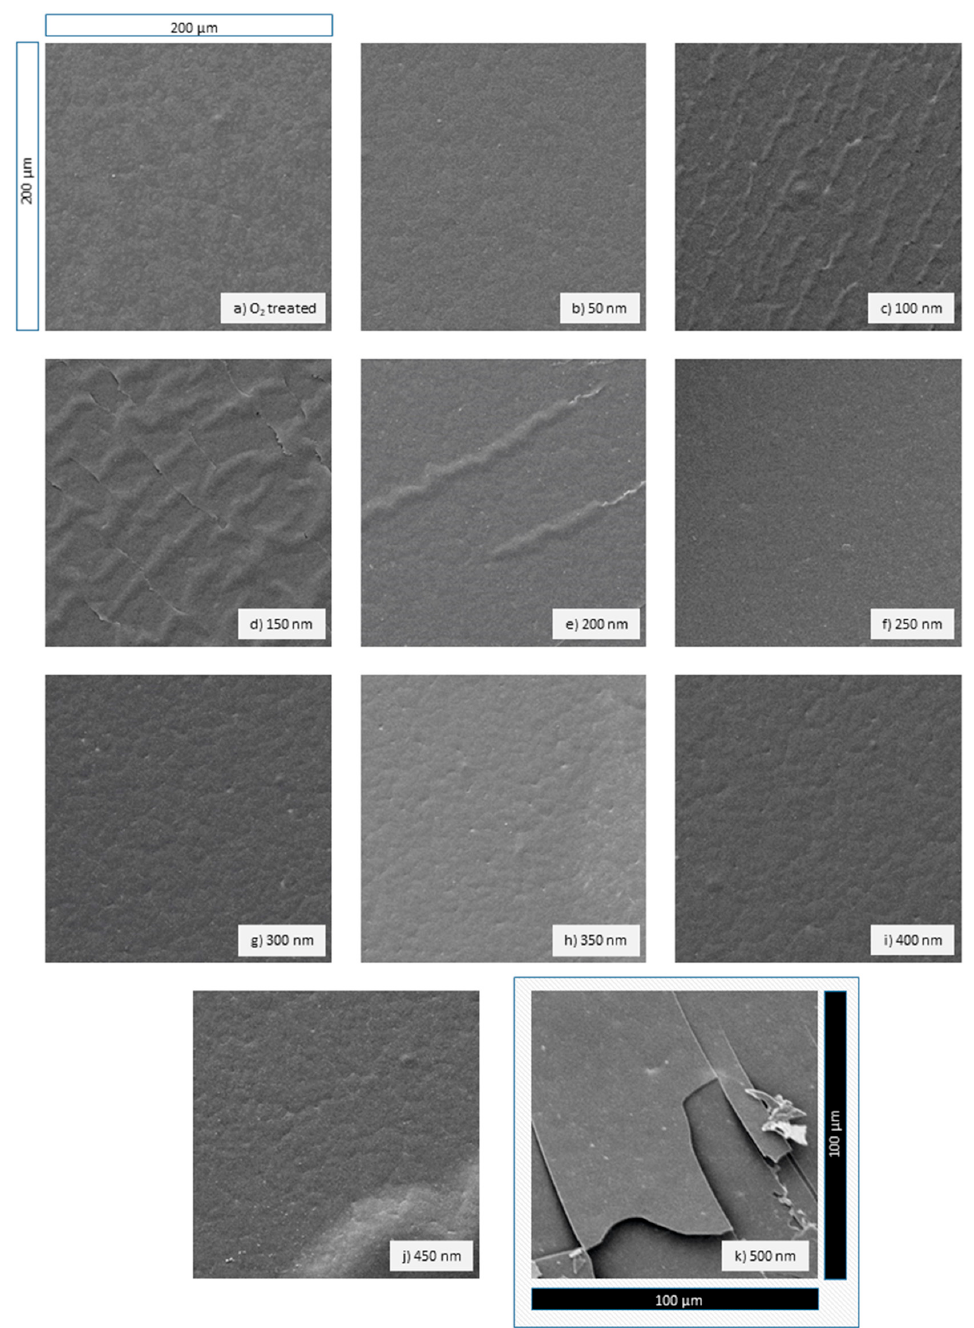
Figure 1. SEM images of PHB treated with O 2 plasma (a) and coated with different thicknesses of a-C:H layers. The series b-k shows the changing topography of a-C:H coating increasing in 50 nm steps.